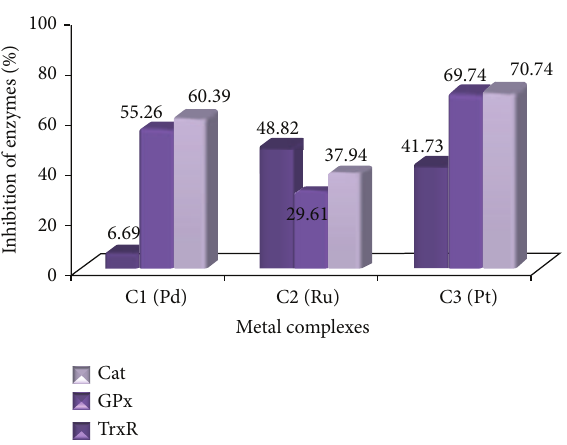
Figure 7: Percentages of inhibition of TrxR, GPx, and Cat enzymes of A549 cells in the given period, after incubation, with IC 50 values of C1, C2, and C3 complexes.